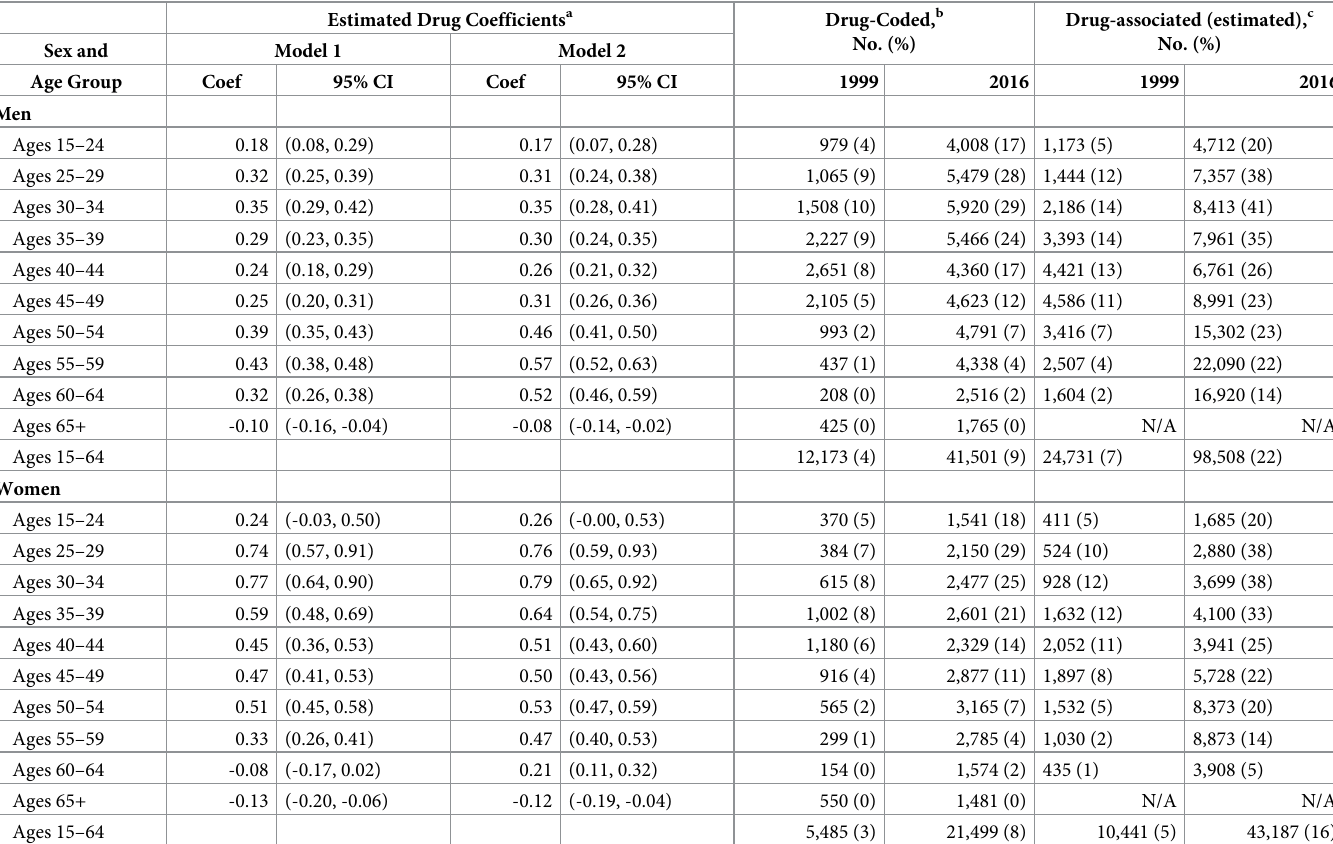
Table 1. Estimated drug coefficients and number and percentage of drug-coded and drug-associated deaths, by sex and age group, US. Estimated Drug Coefficients a Drug-Coded, b No.